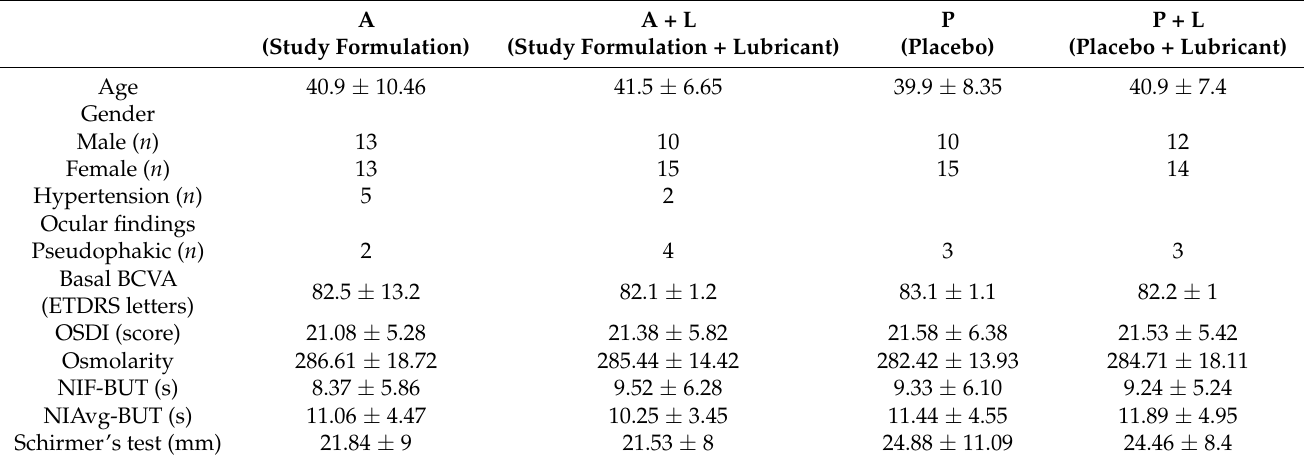
Table 4. Demographic and clinical characteristics of patients and study eyes of efficacy study groups.